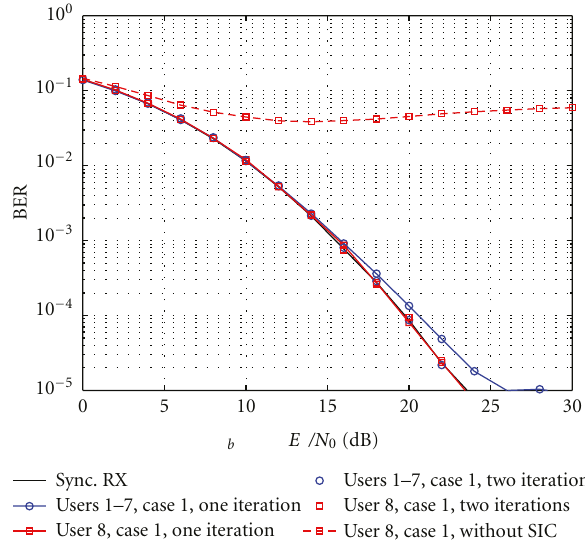
Figure 7: BER performance of each user, τ 1 = τ 2 = ··· = τ 7 = 0, τ